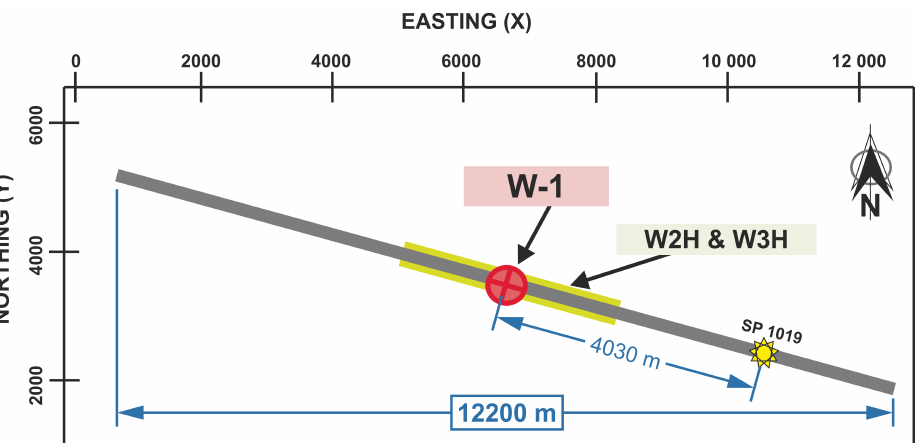
Figure 4. Location map of vertical Well W − 1 ( red dot ), horizontal wells W2H and W3H ( yellow line ), with shooting profile line ( gray ) and outermost shot point SP 1019 ( yellow star ) used for this study (see in [5]